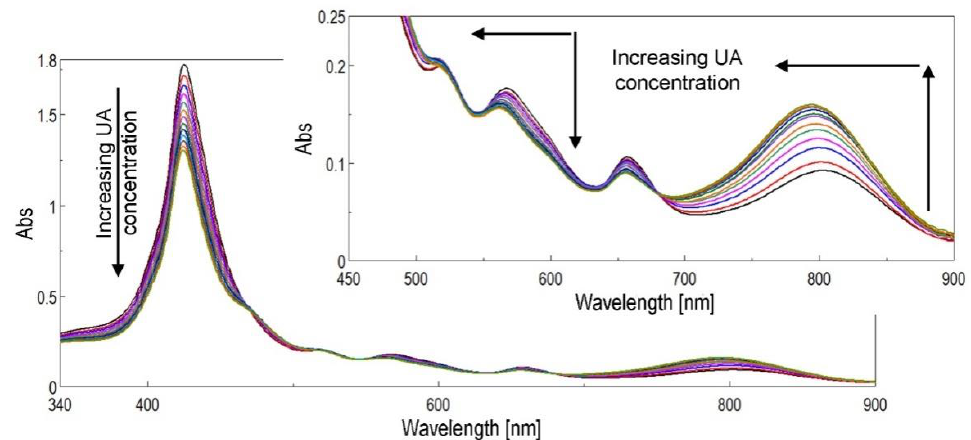
Figure 11. The changes in UV-Vis spectra shape and position during the adding of UA to TAmPP solution in DMSO.